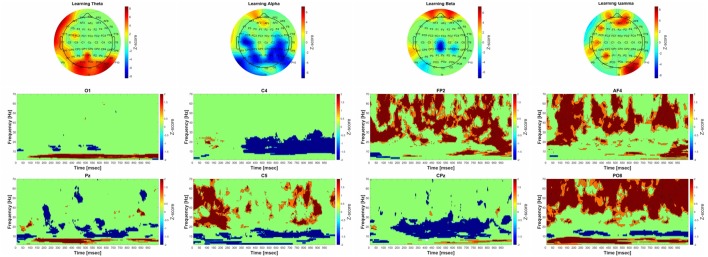
Significant group-level changes in the power of the different frequency bands during acquisition. The power of the investigated four frequency bands (theta, alpha, beta, gamma) during acquisition were compared to the baseline activity using nonparametric permutation test with correction for multiple comparisons at the minimum-maximum point of the null-hypothesis distribution. The upper part of the figure shows the Fast Fourier Transform (FFT) results of the 64 channel EEG recordings in topographic representation in different frequency band during acquisition, while the lower part of the figure corresponds to the group-level time-frequency results in different channels (O1, C4, FP2, AF4, Pz C5, CPz, PO8, respectively). The color scales beside the upper three panels indicate the z-score values, obtained by calculating cluster-mass statistics in individual power changes between acquisition and baseline activity. The red color indicates significant power-increase and the blue color represents significant power-decrease compared to baseline. The z-scores threshold was set to 1.645 (which is equal to the 0.05 p-value).